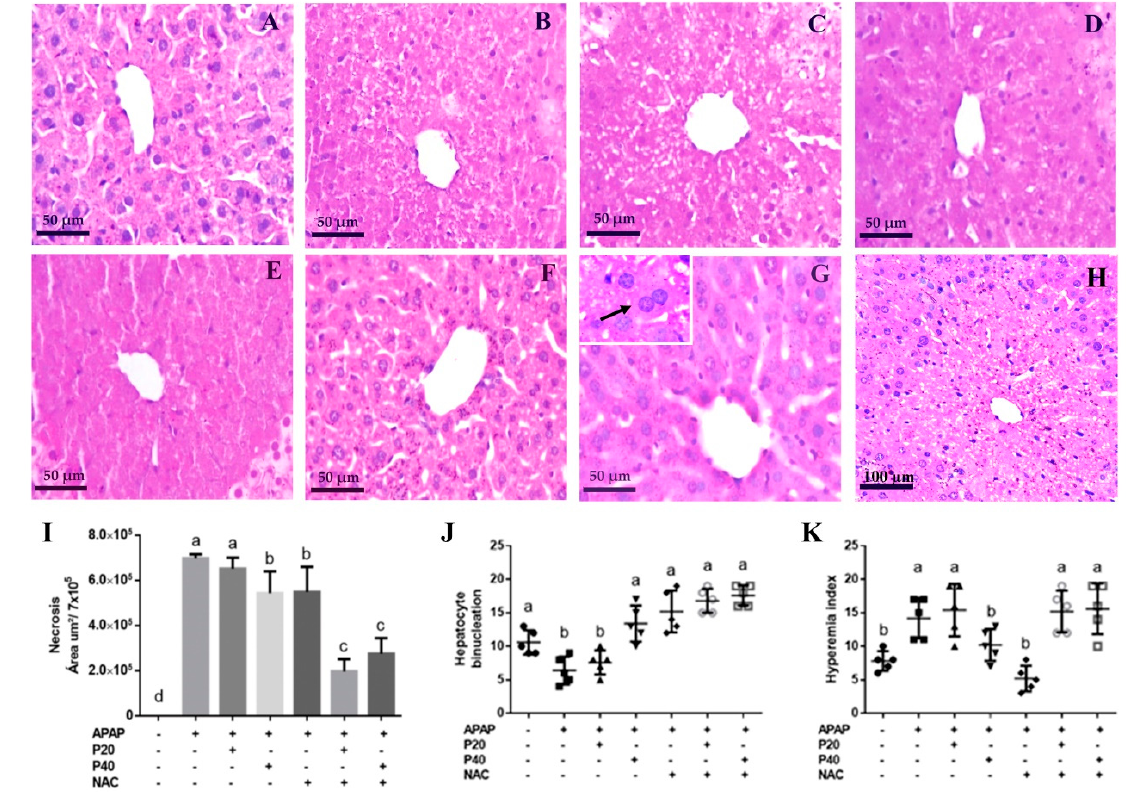
Figure 2. Representative photomicrographs, percentage of hepatic necrosis, and histopathological evaluation of the effects of paracetamol on liver function. Histological sections of the liver of C57BL/6 mice intoxicated with paracetamol (500 mg/kg) and treated after 2 h of intoxication with piperine and/or NAC. ( A ) The control group (40 × ), histological section showing normal architecture. ( B ) APAP group. ( C , D ) Groups treated with piperine 20 mg/kg and 40 mg/kg, respectively. ( E – G ) Groups treated with NAC and the combination of NAC with piperine 20 mg/kg or 40 mg/kg, respectively. ( G ) Representative insert with binucleated hepatocyte (indicated by black arrow). ( H ) Image of the APAP group at lowest magnification (20 × ). Staining: Hematoxylin and Eosin (HE). Objective with 40 × magnification. ( I ) Represents area of hepatic necrosis. ( J ) Represents the hepatocyte binucleation. ( K ) Represents the hyperemia index. Control group: no treatment; APAP group (500 mg/kg); Piperine-treated group (20 mg/kg); Piperine-treated group (40 mg/kg), NAC-treated group (300 mg/kg); NAC+P20 group, and NAC+P40 group. Results are expressed as median and interquartile range (n = 7). In graphs ( J,K ), contingency statistical analysis was evaluated by the chi-square test and Fisher’s exact test, with different letters indicating statistical differences between the groups. Differences were considered significant at p < 0.05. (+) Presence and ( − ) absence of paracetamol, piperine 20 mg/Kg, piperine 40 mg/Kg, N-acetylcysteine.